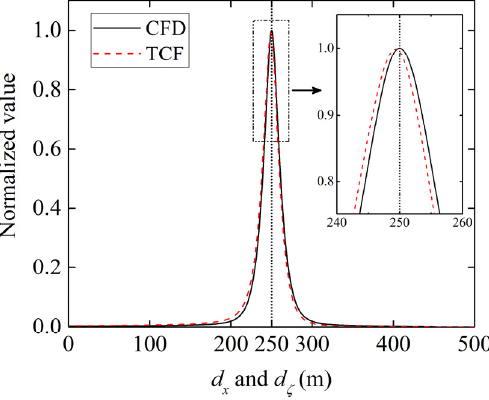
Figure 7. The normalized curves of the TCF and CFD.